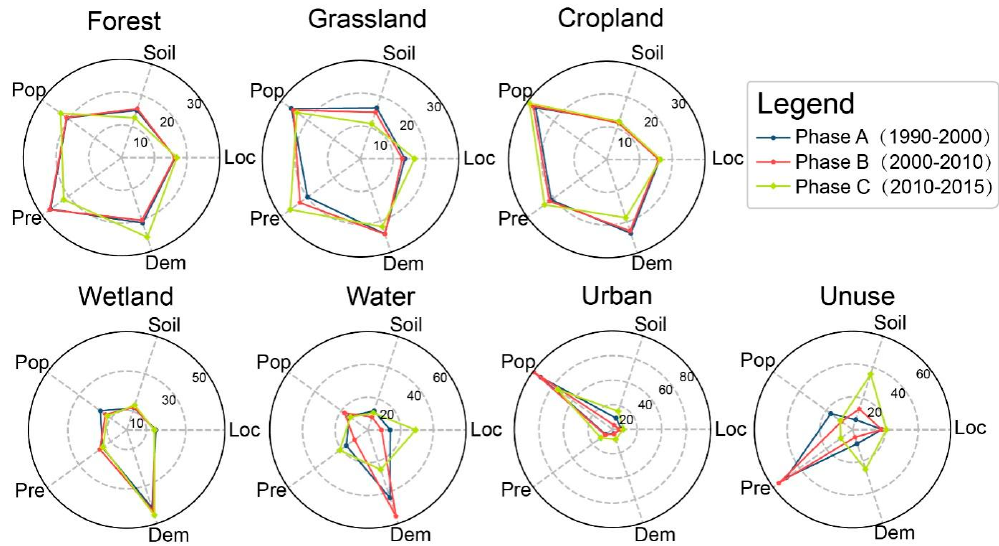
Figure 6. Contribution rates of driving factors of different LULC types.